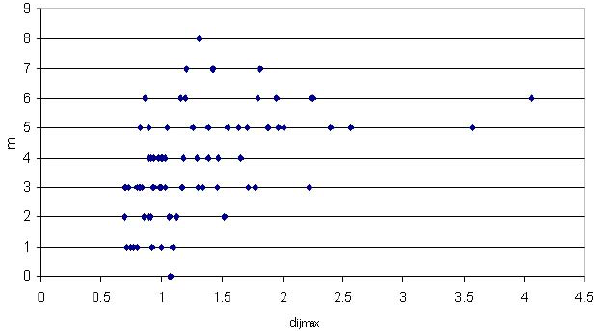
Fig. 7. H1 plotted versus d ij, max . Each point represents a pooling group.